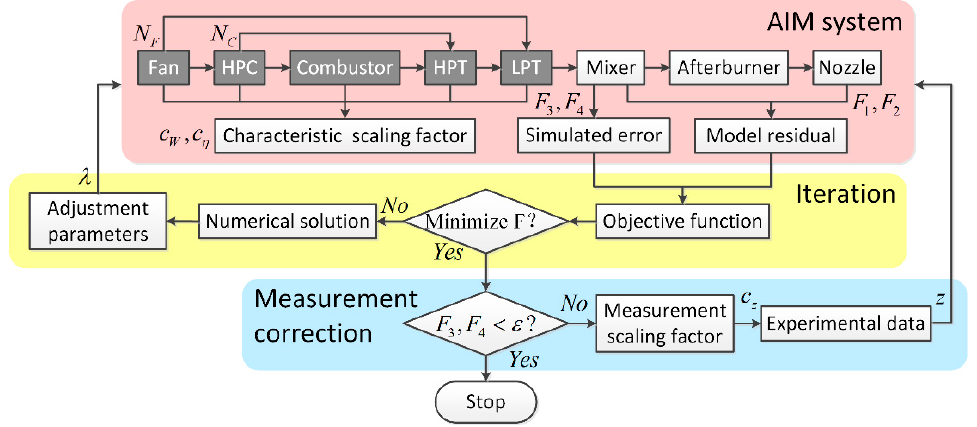
Figure 5. The calculation process of scaling factors.